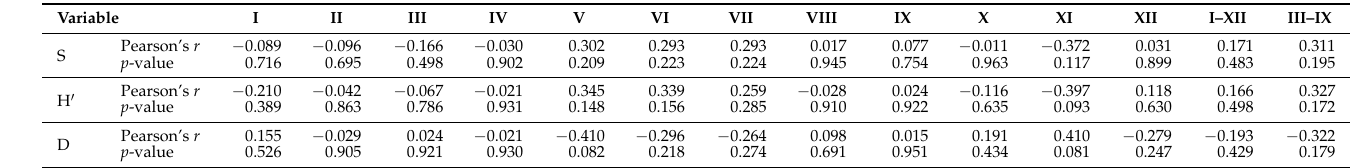
Table 2. Correlations between the rainfall amounts (I–XII) and species biodiversity (S, H’ and D) in ex-arable grassland from Gr ă dinari (period 2003–2021).